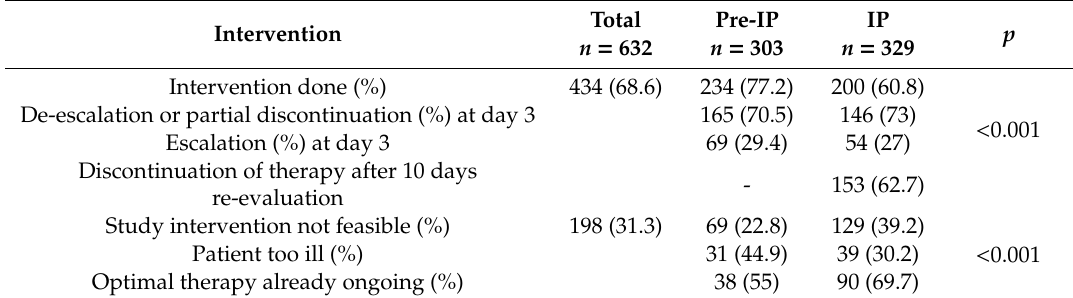
Table 3. Interventions at day 3 and day